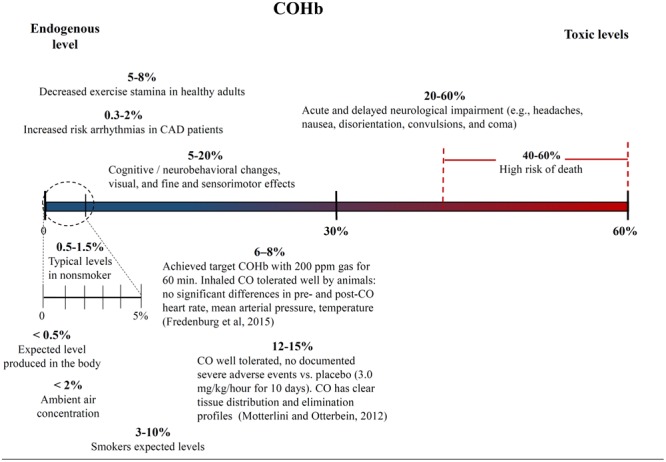
Carboxyhemoglobin (COHb) concentrations in the blood and corresponding medical effects for both environmental conditions and controlled supplementary CO therapy. Negative and positive medical effects are shown on the top and bottom, respectively (Motterlini and Otterbein, 2010; Fredenburgh et al., 2015). The effects without corresponding citations are from a CDC publication (Wilbur et al., 2012).